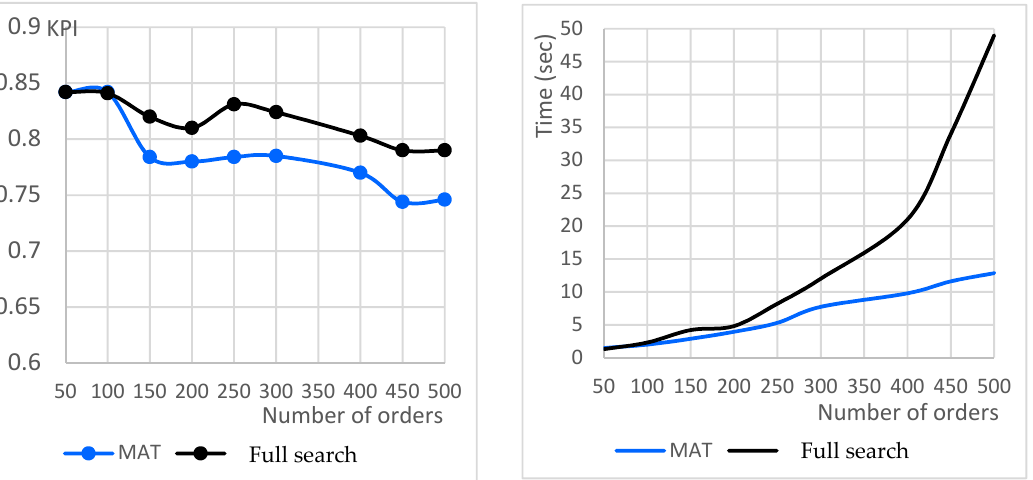
Figure 12. Quality and computational time achieved using the developed method (blue line) comparing with the full combinatorial search (black line).